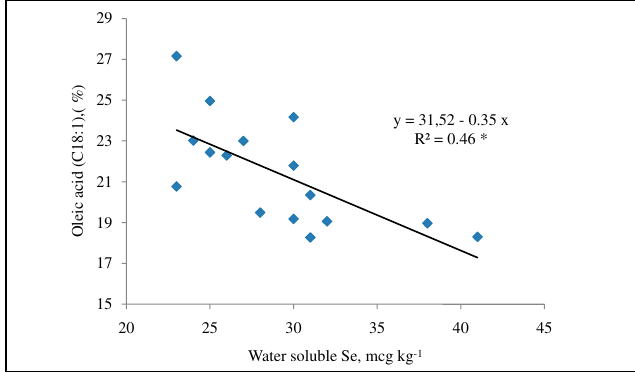
Fig.2 Fig. 2 - Correlation between water soluble selenium concentration and oleic acid concentration in Allium seeds (r = -0.64,